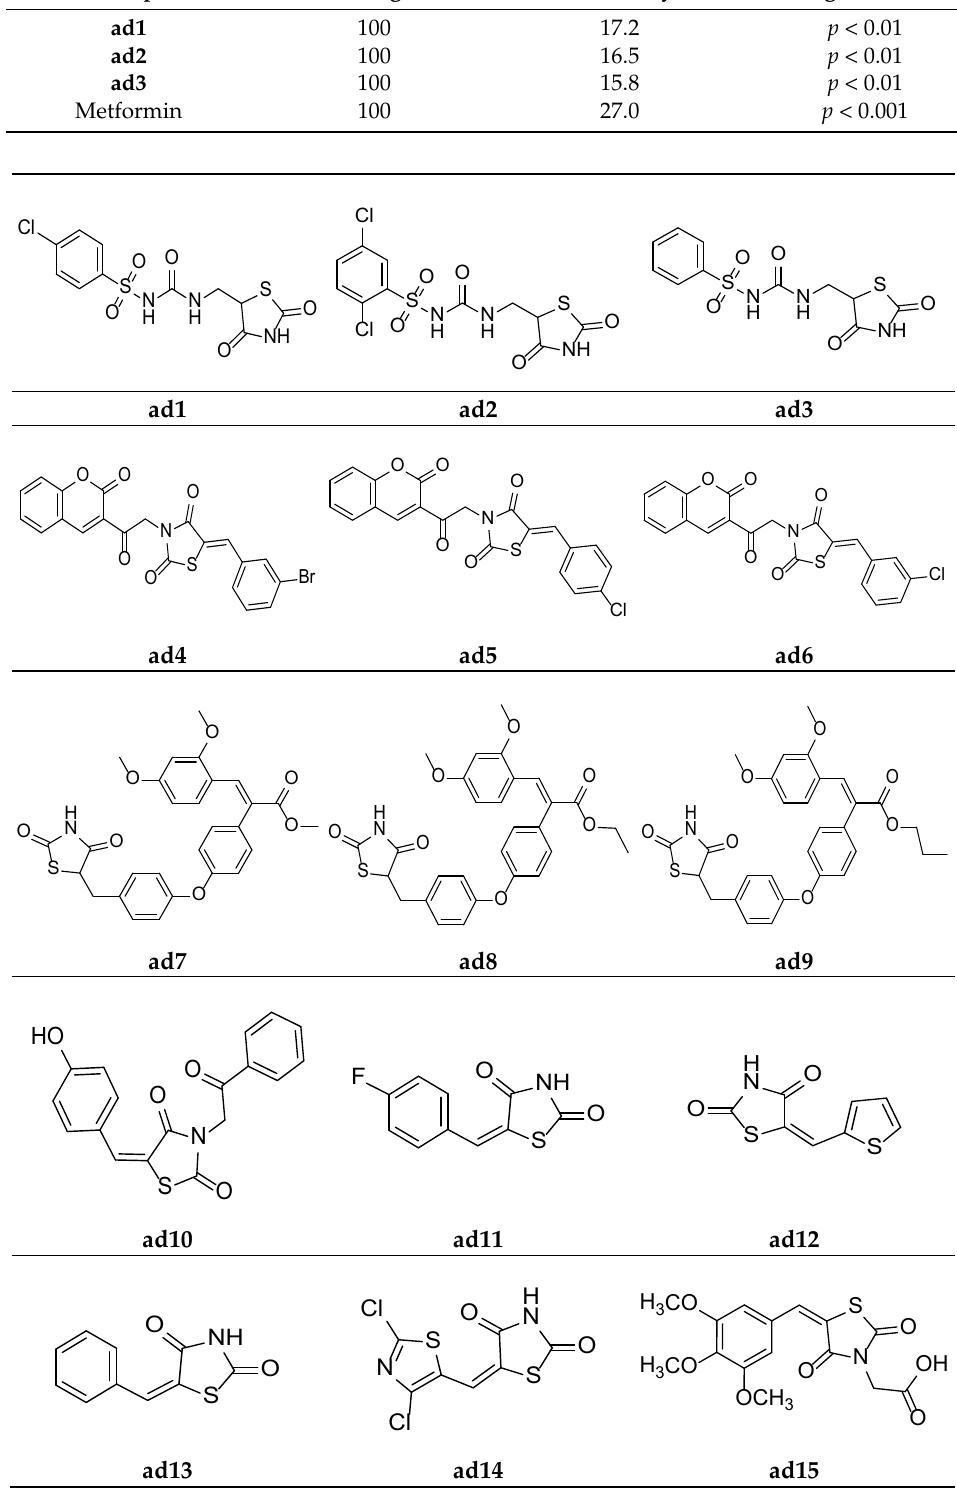
Figure 14. Molecular structures of the compounds ( ad1 – ad15 ). Table 31. Antidiabetic potential of the compounds ( ad4 – ad6 ) in alloxan-induced diabetic rats. Comp.